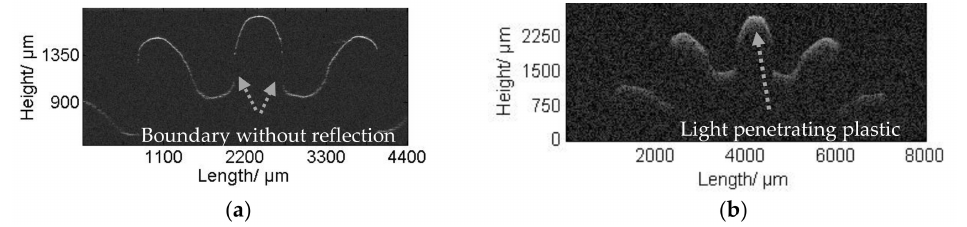
Figure 6. The profile of the gears with different materials: ( a ) profile of the blackened steel gear; ( b ) profile of the plastic gear by